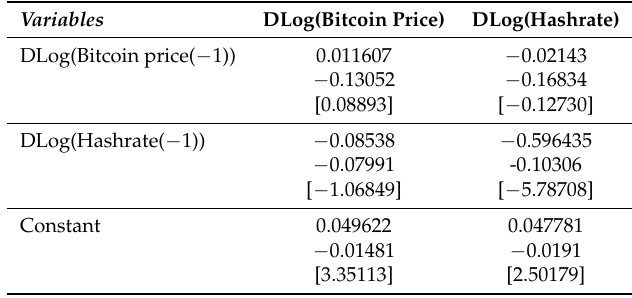
Table A3. VAR(1) for the Log-returns of the pair: Log(Bitcoin price), Log(Hashrate). First sample: 01/08/2016–04/12/2017.